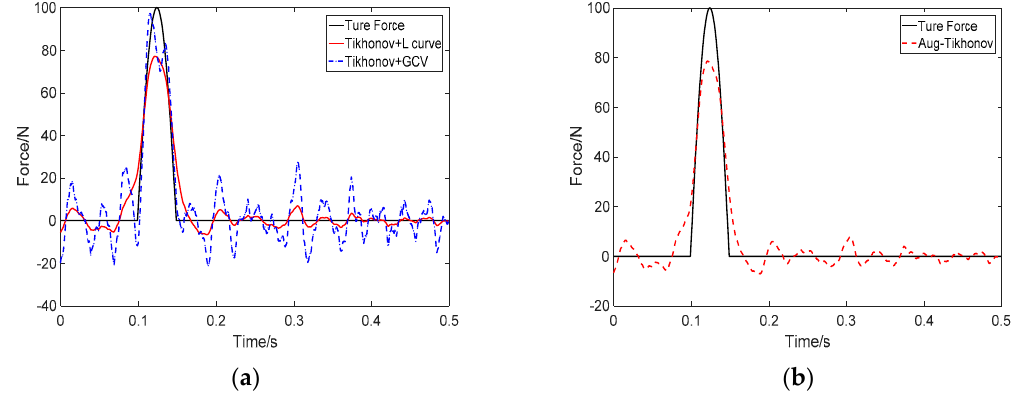
Figure 12. Identification result of impact load at SNR 30 dB: ( a ) Tikhonov method; ( b ) the proposed method.